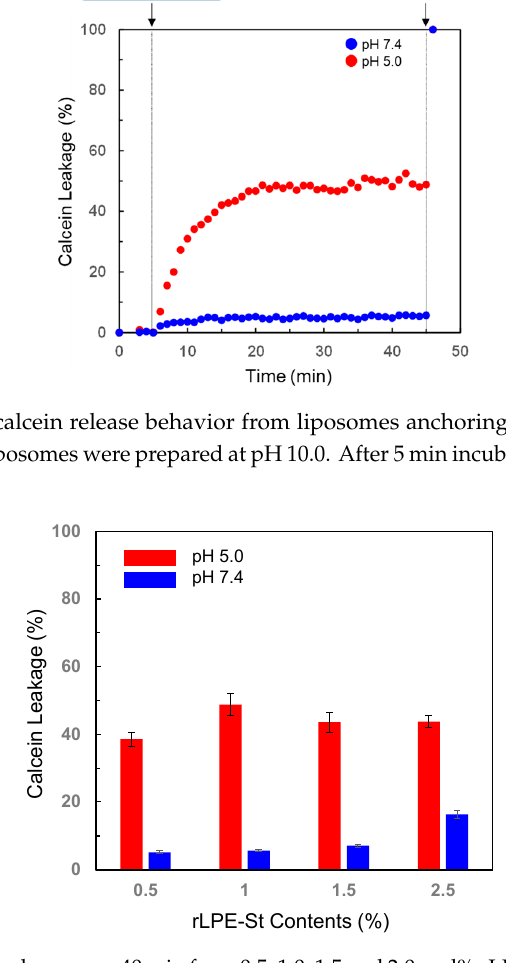
Figure 4. pH-selective calcein release behavior from liposomes anchoring the 1.0 mol% of rLPE-St. The calcein-entrapped liposomes were prepared at pH 10.0. After 5 min incubation, the pH was lowered to a value of 7.4 or 5.0.